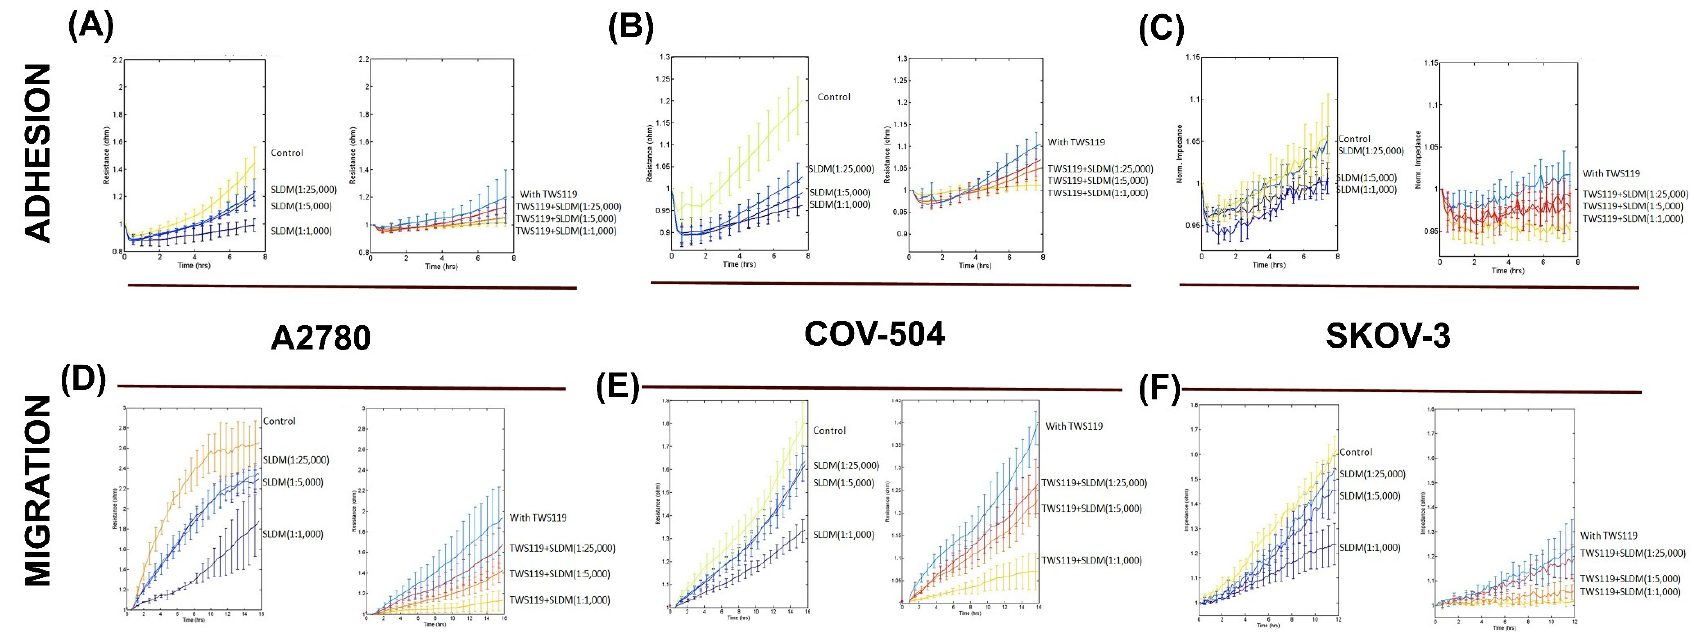
Figure 4. Inhibition of ovarian cell adhesion and migration after treatment with SLDM and TWS119. Treatment of A2780, COV504 and SKOV3 cells with a combination of SLDM and/or GSK-3 β inhibitor TWS119 resulted in decreased cell attachment in all three cell lines (( A ), ( B ) and ( C ), respectively). Similarly, inhibition of ovarian cell migration after treatment with SLDM and TWS119 was also observed in all three cell lines tested, A2780, COV504 and SKOV3, respectively (( D ), ( E ) and ( F ), respectively).